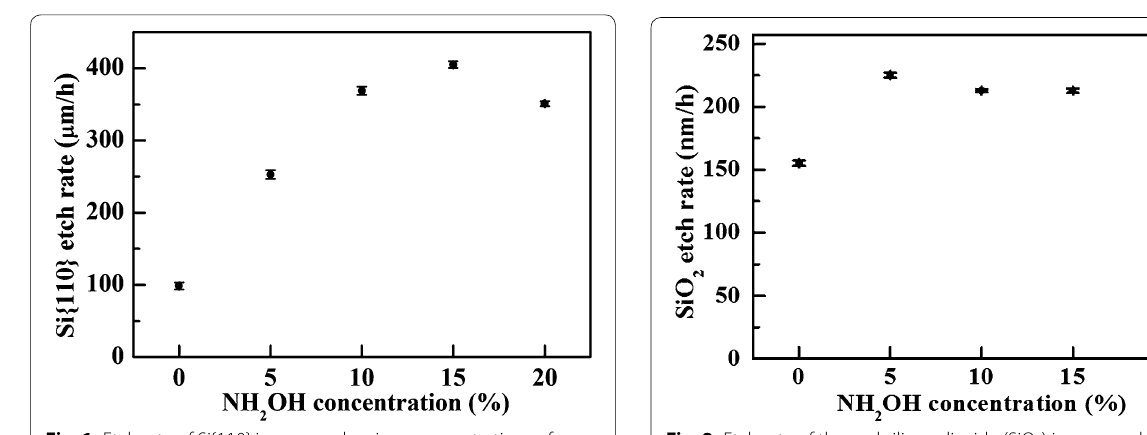
Fig. 2 Etch rate of thermal silicon dioxide (SiO 2 ) in pure and different concentrations of NH 2 OH-added 20 wt% KOH at 75